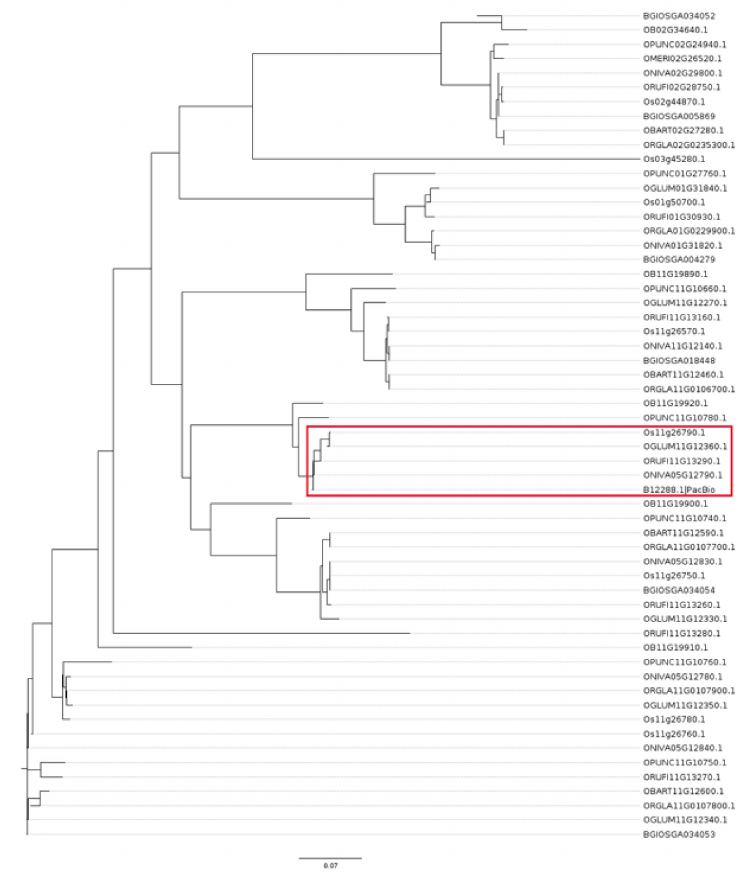
Figure A5. Phylogenetic tree of Oryza dehydrin proteins. Dehydrin selection was based on Verma et al. (2017) and includes the following Oryza species: BGI— Oryza sativa L. ssp. indica Kato, Os— O. sativa L. ssp. japonica , OB— O. brachyantha A. Chev and Roehrich, OPUNC— O. punctate Kotschy ex